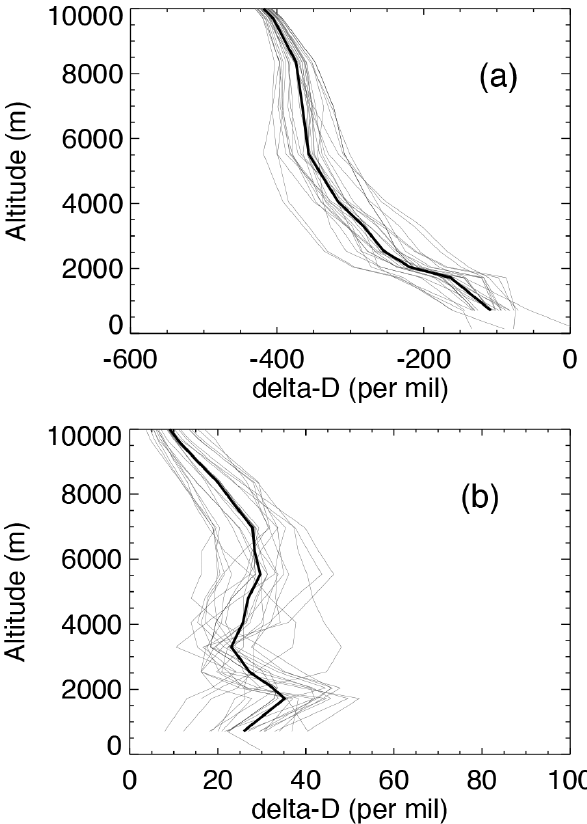
Figure 2. (a) Mean water vapor δ D from each of 27 TES transect special observations (thin gray lines) and the overall mean profile (thick black line) over the Alaskan interior boreal forest in July and August 2011, and July and August 2012. (b) The standard deviation of water vapor δ D from each of the same 27 TES transect special observations (thin gray lines) and the overall mean profile (thick black line). In both figures, TES HDO has been bias-corrected using Eq. (3). The values of the overall mean and standard deviation are also listed in Table 3